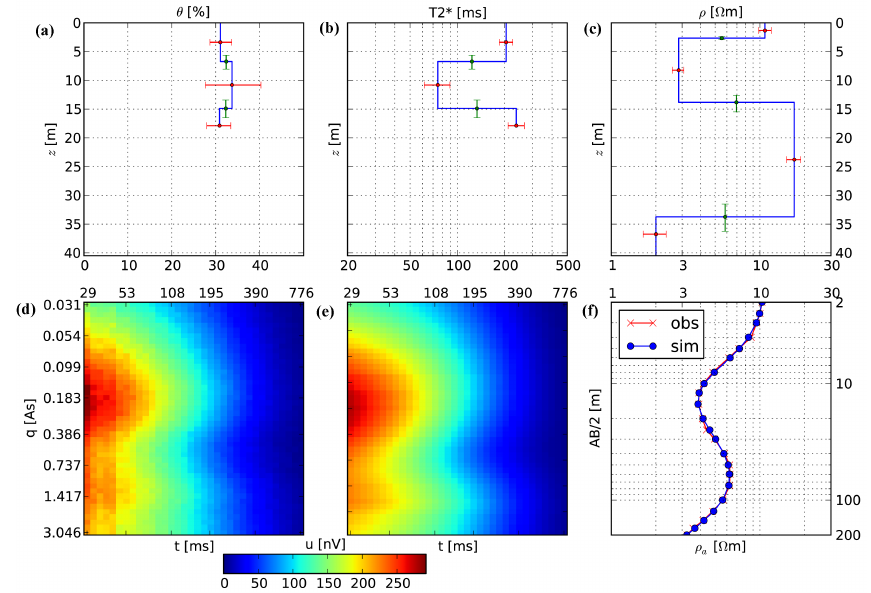
Fig. 5. Results of independent inversions (subplots as in Fig. 3) of the MRS and VES data for the location SKD using 3 and 4 layers, respectively.